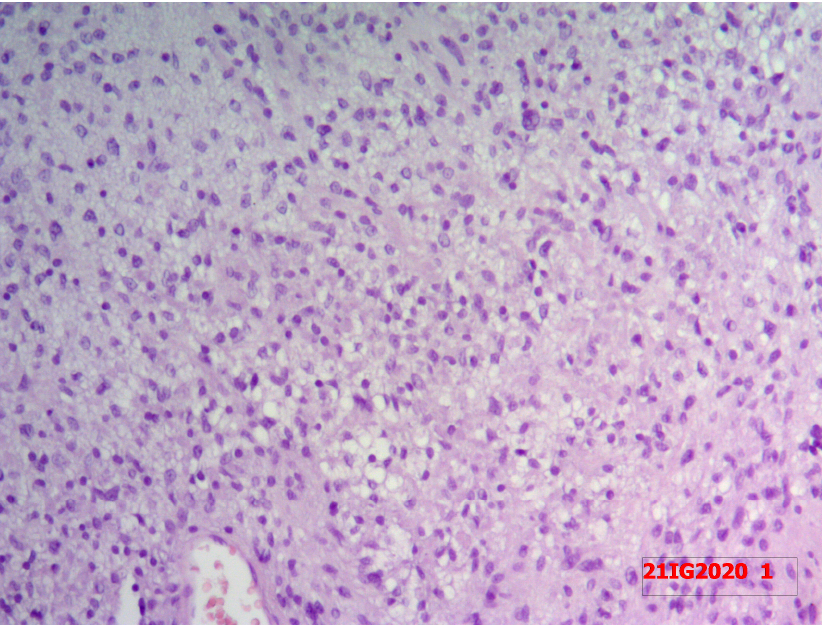
Figure 4. Resected specimen of extra-thyroidal neoplasm measuring 5 × 3.5 cm with the right thyroidal lobe and isthmus.